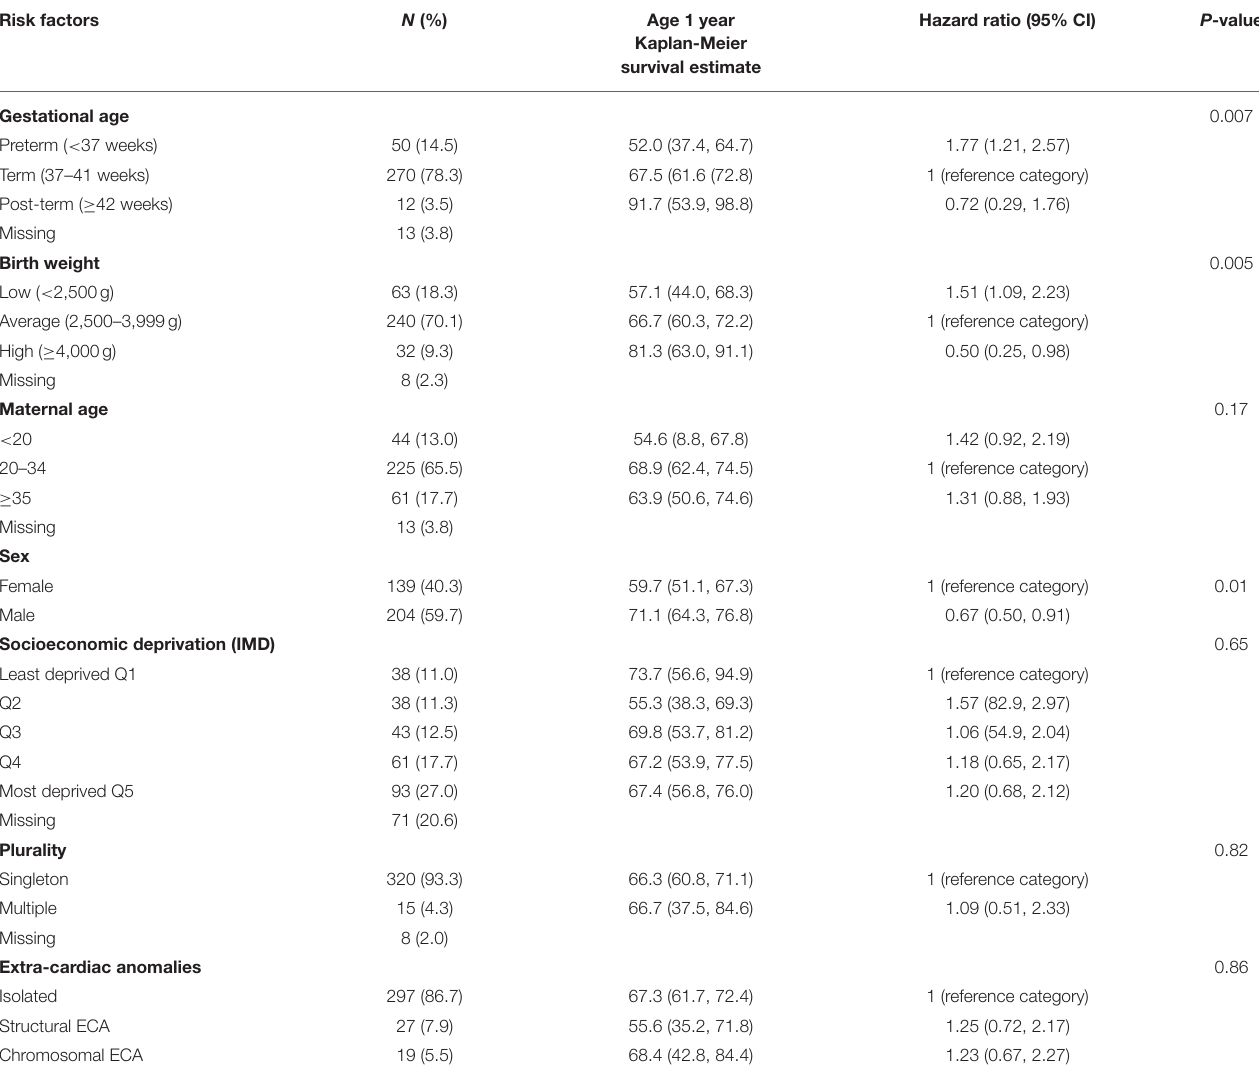
TABLE 3 | Risk factors for mortality in cases of HLHS or hypoplastic left ventricle with additional CHD born 1998–2012. Risk